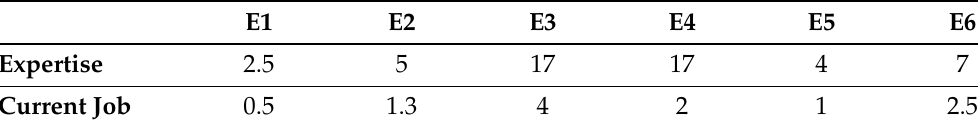
Figure 7. Prior distributions of the beliefs of six experts. Table 3. Experts’ years of experience in the ICT area and years in their current job. Note for example that while E3 and E4 have the same number of years of expertise, E3 has more experience working the computers being assessed in this